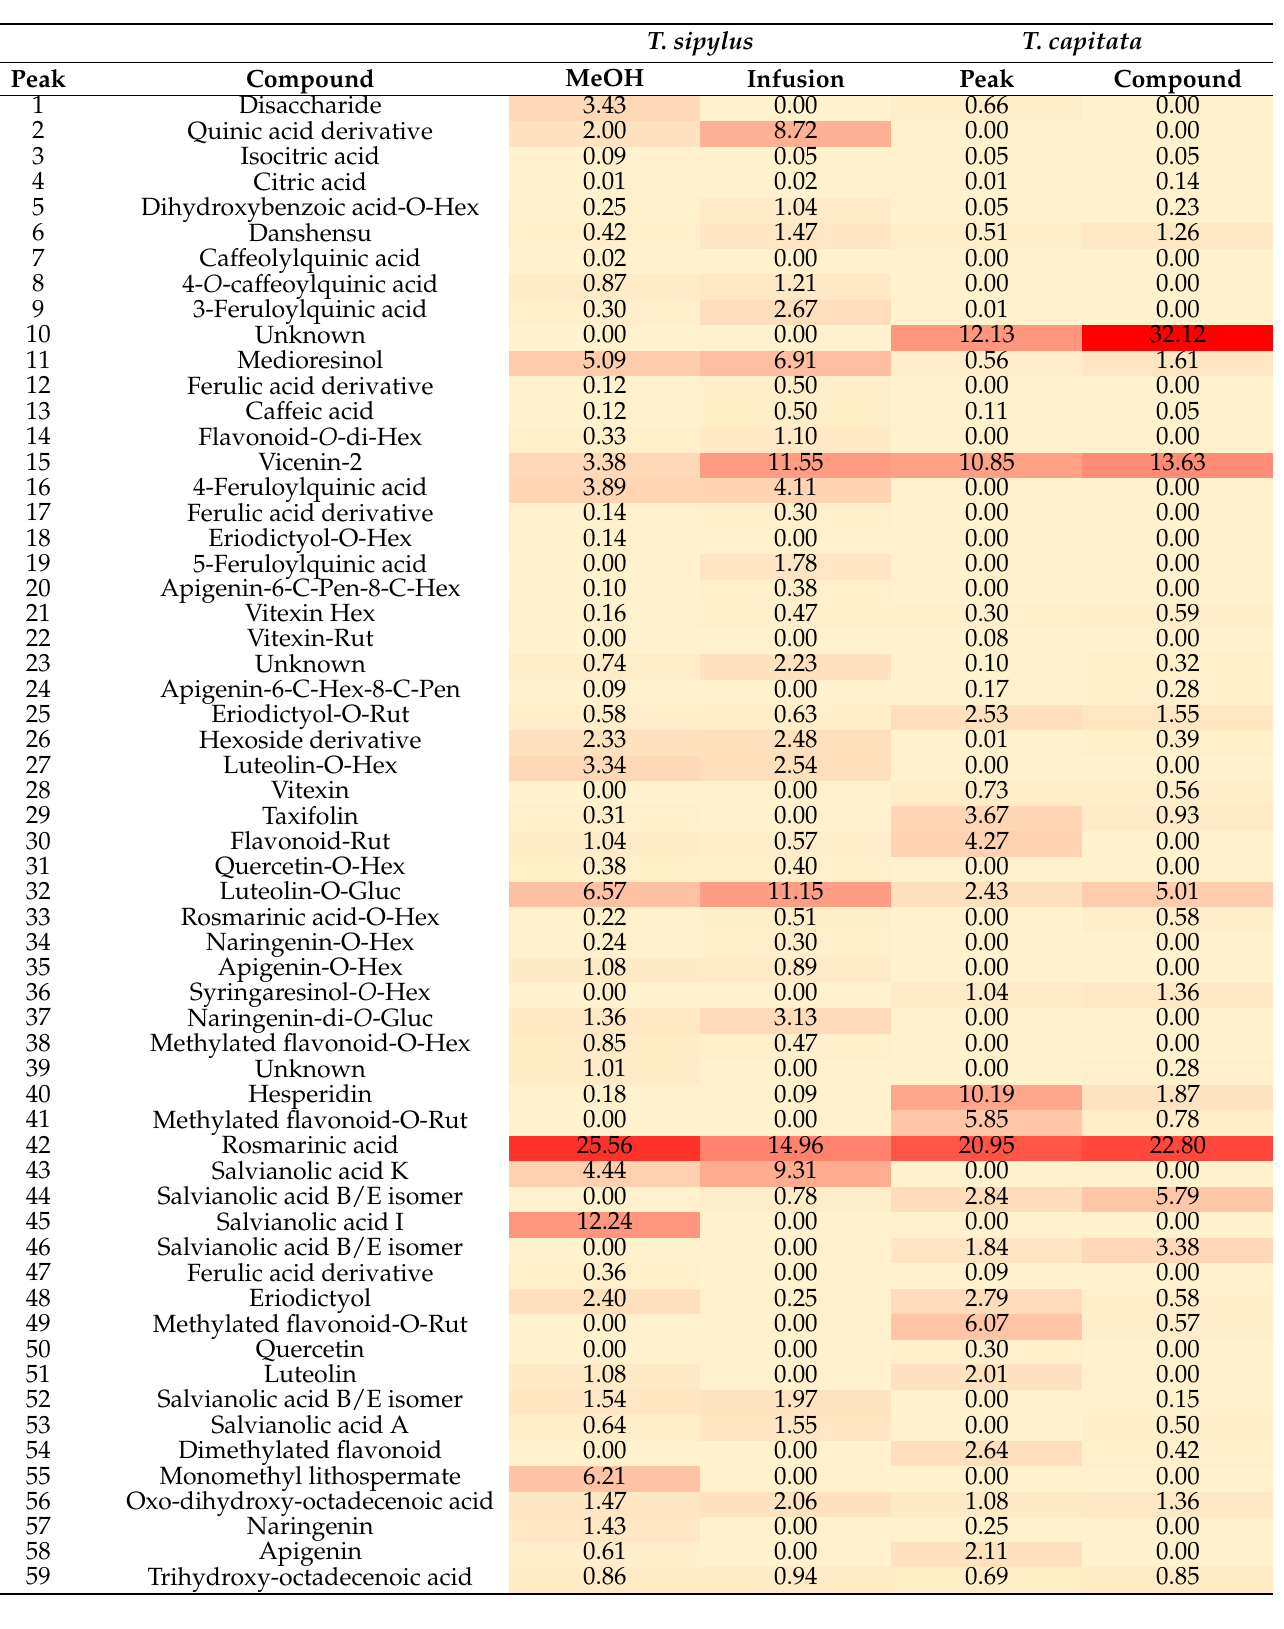
Table 3. Relative peak areas (%) and heat map for Thymus sipylus and Thymbra capitata , obtained by HPLC-ESI-MS analysis. Hex = hexoside; Pen = pentoside; Rut = rutinoside. T.